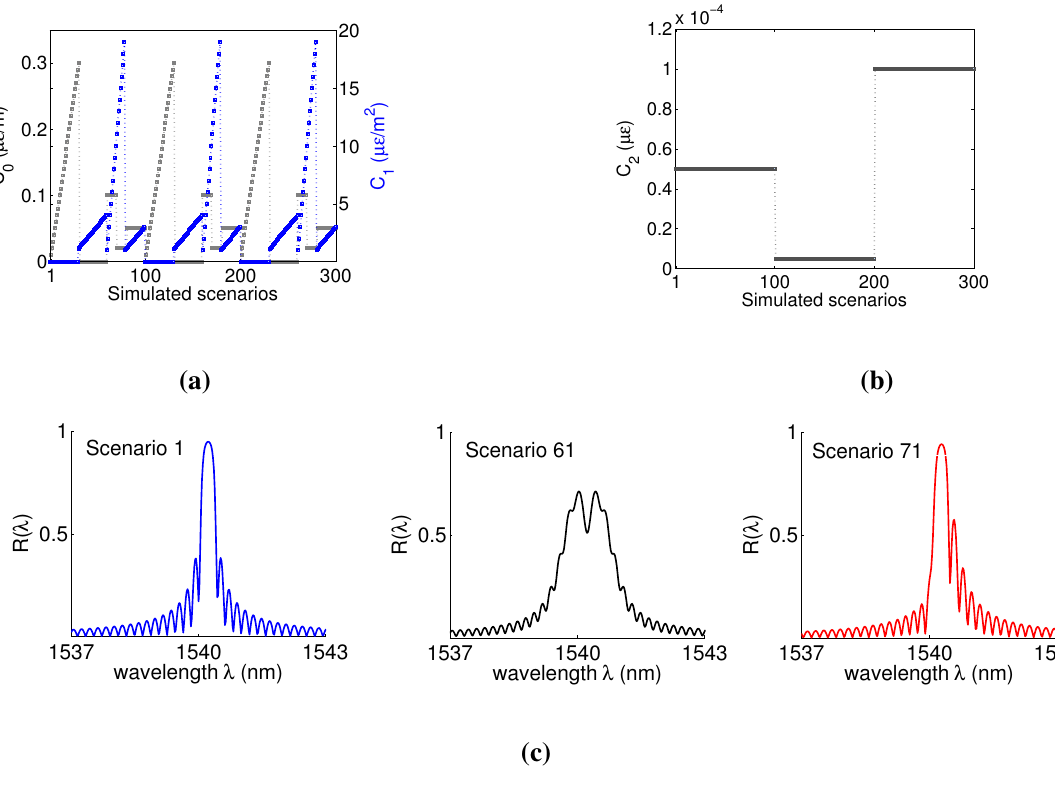
coefficient varies from zero to 0 and C repeat identically every 100 0 1